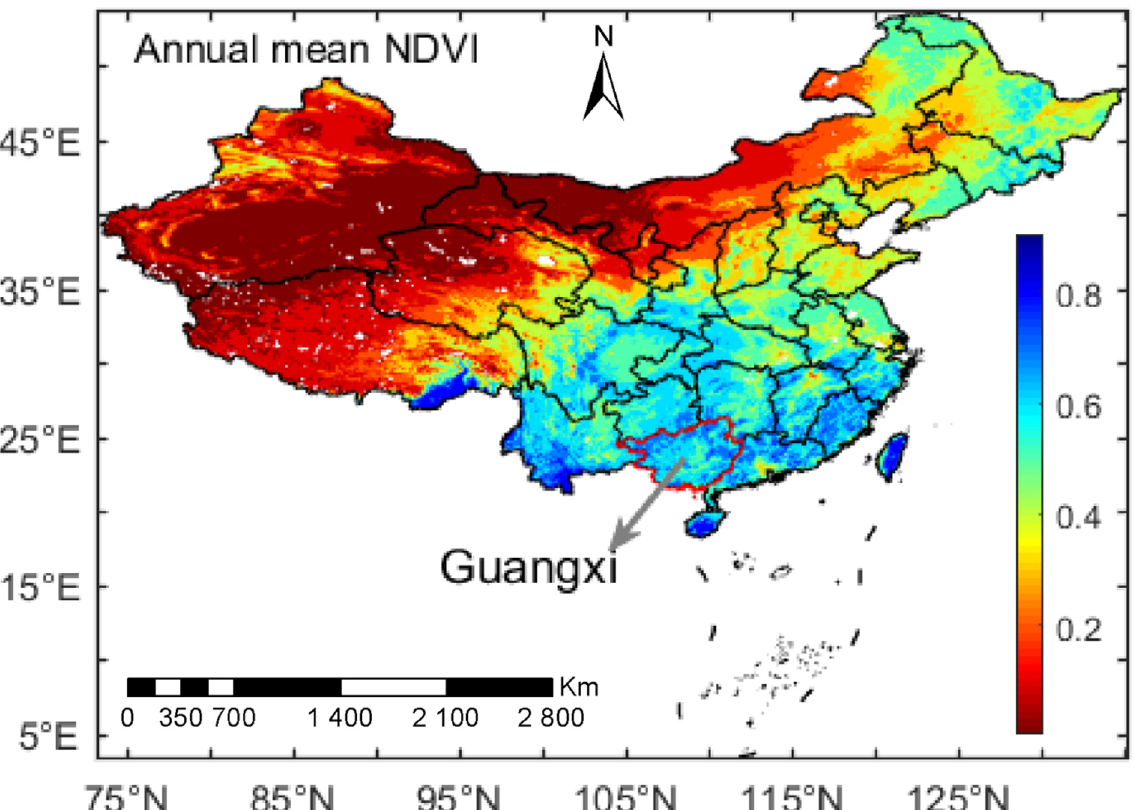
Figure 11. The mean of the annual NDVI in China during 1982–2015. Vegetation has different mechanisms in responding to the low-temperature and high- temperature indices [25,31]. Low temperatures elongate the plant growing season [54] and enrich the soil nutrients [55]. These mechanisms might partly explain the positive correla- tions between the annual NDVI and the low-temperature indices over Guangxi. In addition, with obvious differences from the high-temperature indices, some low-temperature indices did not have any significant relations with the NDVI in each season and month, which further indicated the non-uniform responses of terrestrial vegetation growth to the high- temperature and low-temperature indices at the local scale. Furthermore, the correlations between the NDVI and the extreme temperature indices varied seasonally and monthly in Guangxi. The positive correlations between the NDVI and the high-temperature indices were strongest in spring, followed by summer and winter, but they were not significant at all in autumn. This seasonal distinction of the correlations in Guangxi is highly differ- ent from that at the northern hemisphere scale, where the strongest negative correlations between the mean maximum temperature and NDVI were observed in the summer of temperate dry regions